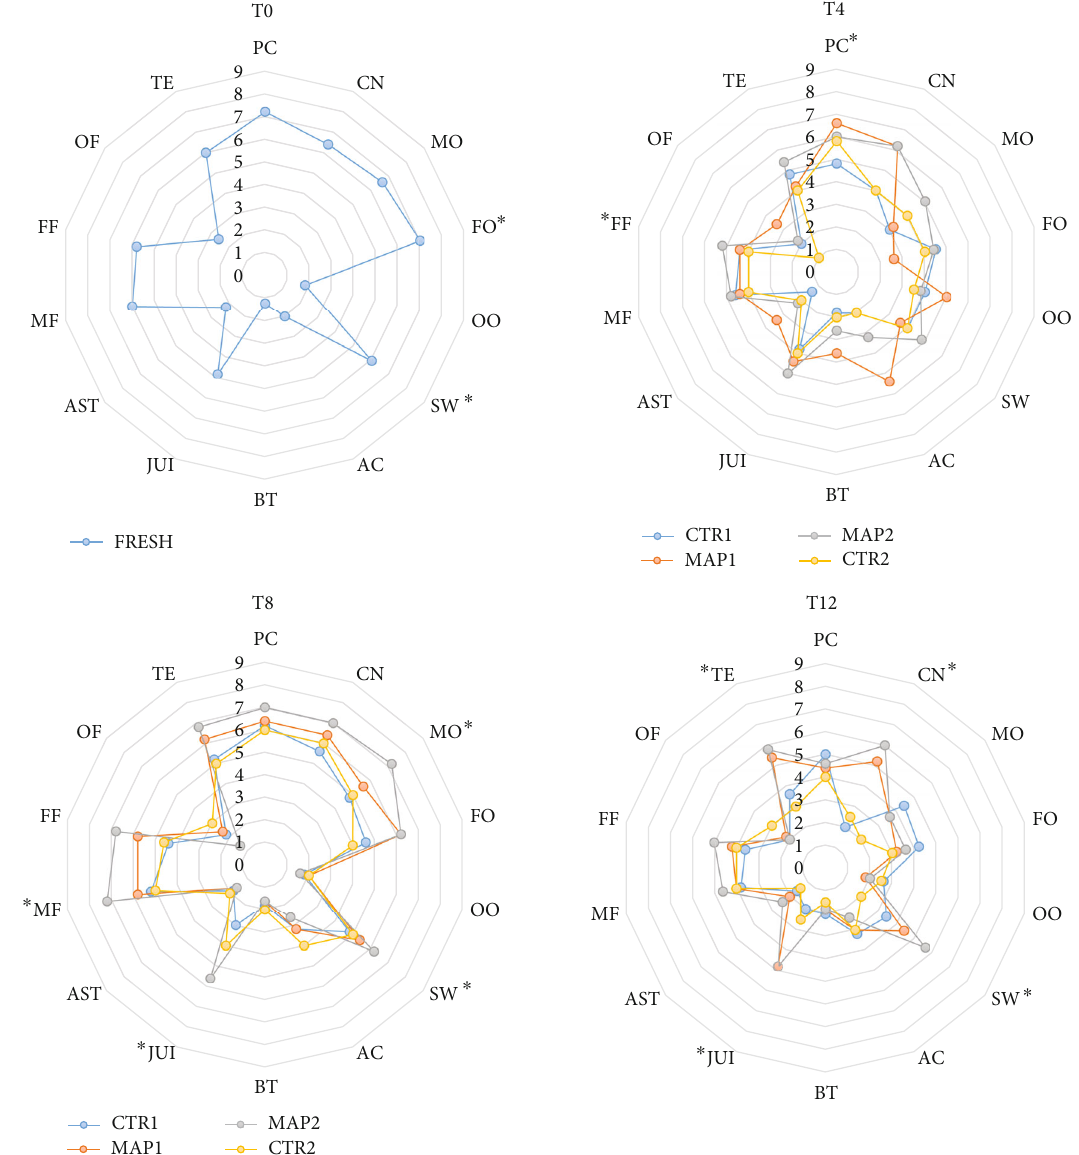
Figure 5: Sensory analyses of treated and untreated mulberry fruit at 0, 4, 8, and 12 (T0, T4, T8, T12) days of storage at 4 ° ± 1 ° C and 90 % ± 5 % RH. Descriptors legend: Peel color (PC), Consistency (CN), Mulberry odor (MO), Fruity odor (FO), O ff -odor (OO), Sweet (SW), Acid (AC), Bitter (BT), Juiciness (JUI), Astringent (AST), Mulberry fl avor (MF), Fruity fl avor (FF), O ff - fl avor (OF), and Total evaluation (TE). For each descriptor, the values marked with ∗ indicate signi fi cant di ff erences between treatments. Data are the mean of 60 replications from one replicate of 60 fruit